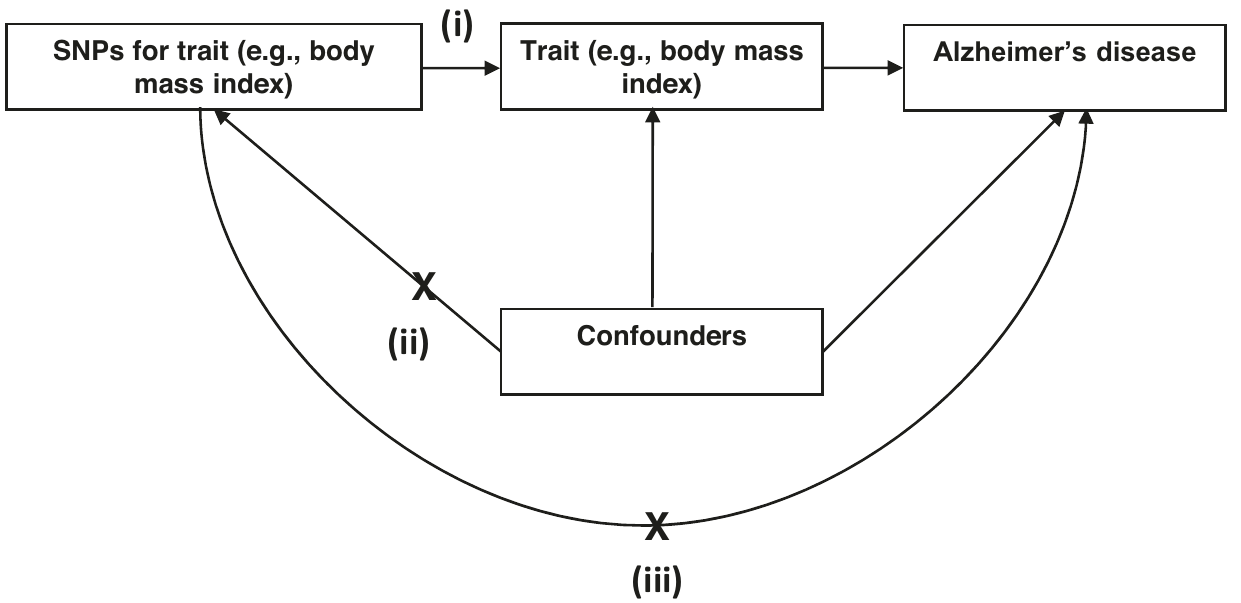
Fig. 1 | Study design for the phenome-wide association study of Alzheimer's disease genetic liability and follow-up Mendelian randomization of identi fi ed phenotypes on Alzheimer ‘ s disease. Diagram ( A ) describes our study design when conducting a phenome-wide association study, and diagram ( B ) describes our study design when using Mendelian randomization. In A , the polygenic risk score for Alzheimer's disease may either have a downstream causal effect on the trait(e.g.,bodymassindex),oritmayaffectthetraitthroughpathwaysotherthan through Alzheimer's disease (i.e., pleiotropic effects). Diagram ( B ) describes our follow-up analysis using Mendelian randomization to establish the causality and